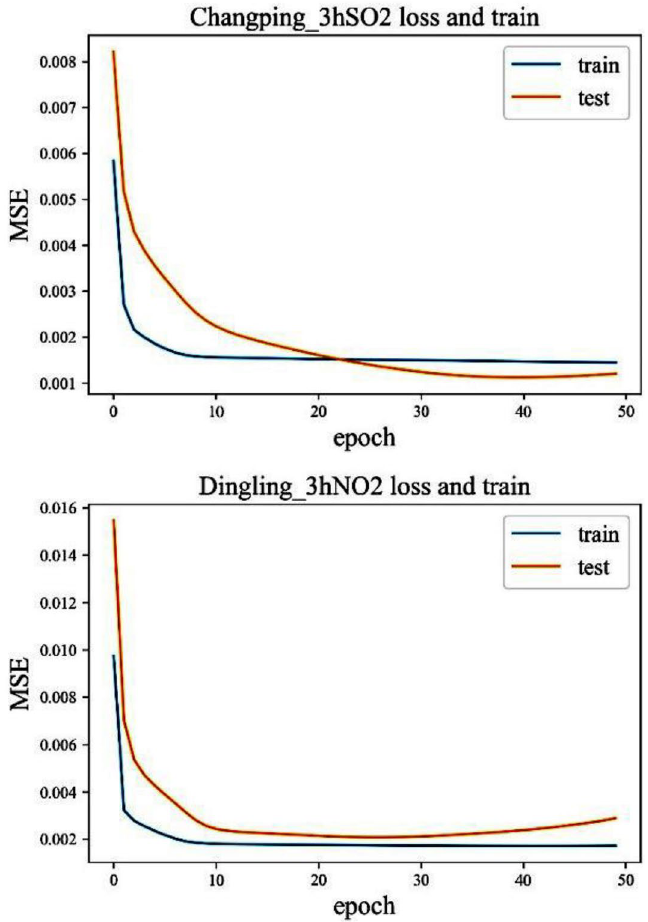
Figure 6. Error trends of training and test sets for the two sites at epoch